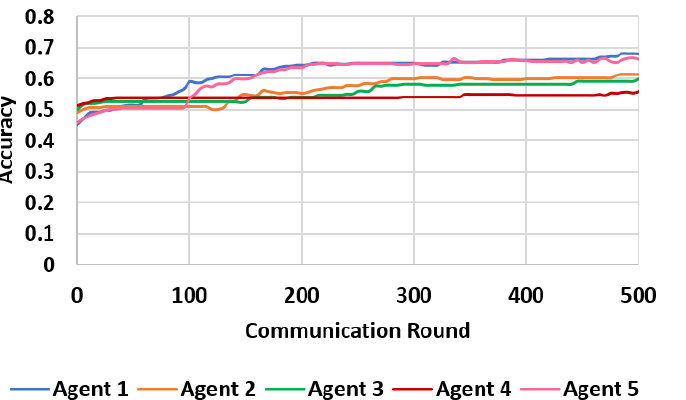
Figure 20. FedResilience impact on participating FL agents’ (five agents and three stragglers) model accuracy for the prediction of CIA outages.